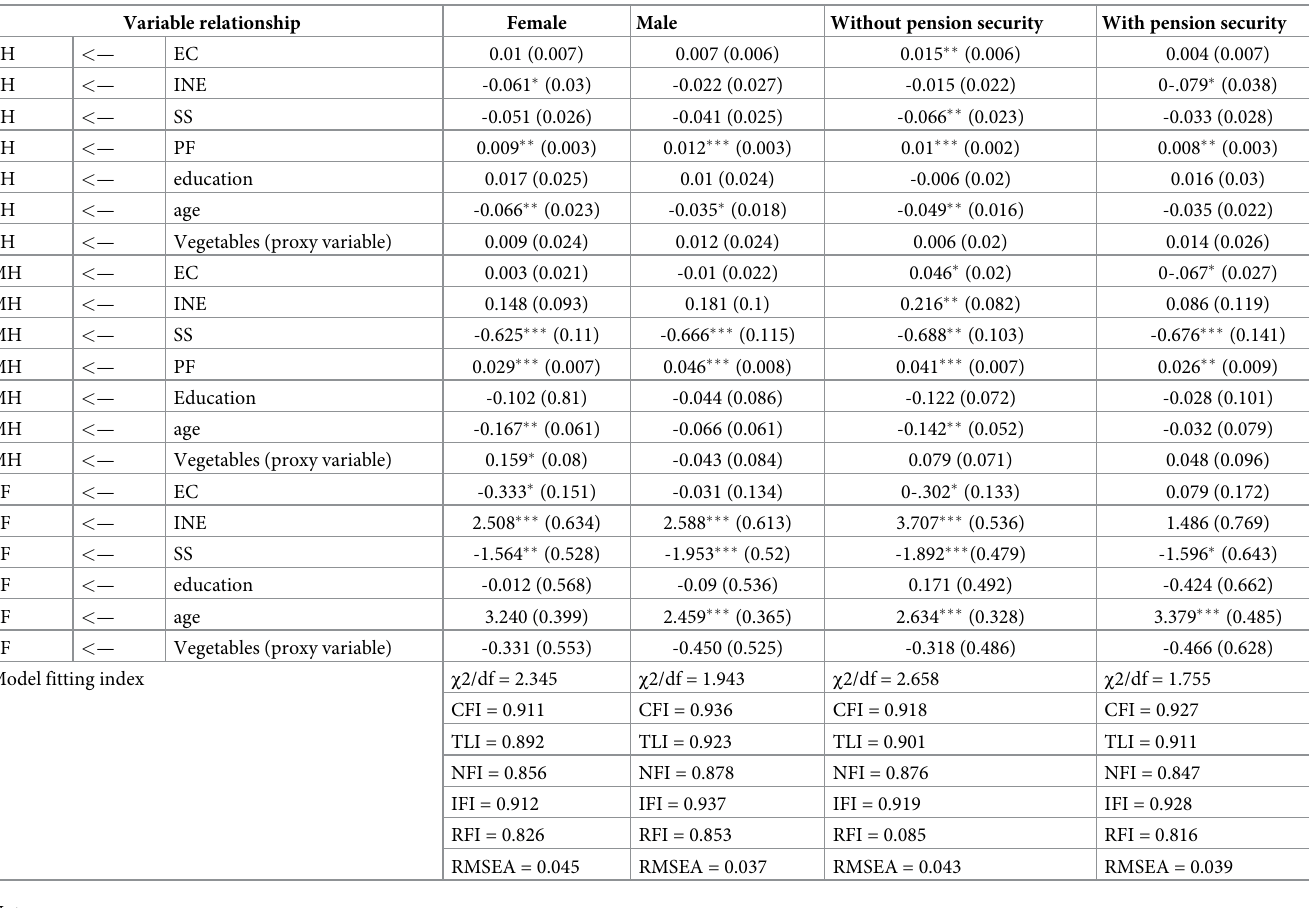
Table 3. Heterogeneity